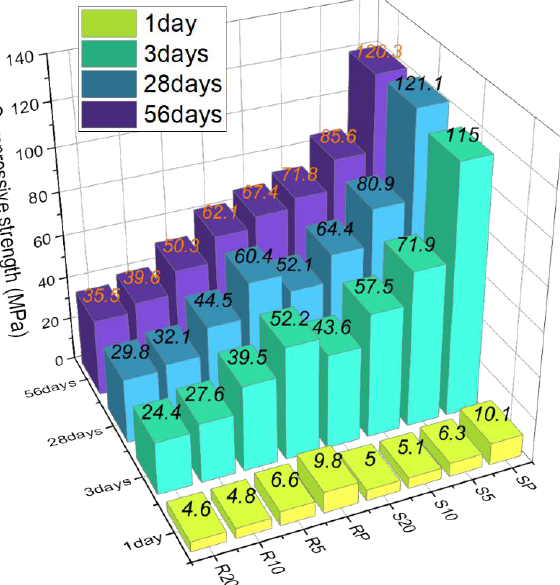
Figure 4. Compressive strengths of specimens subjected to steam curing and room temperature curing as a function of curing time.